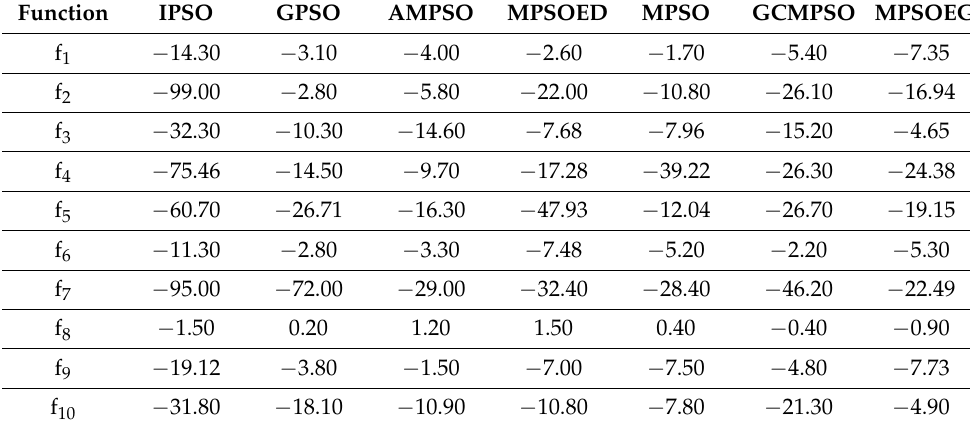
Table 2. Statistical Analysis of the Best Objective Function Values for 100 Dimensions Bench- mark